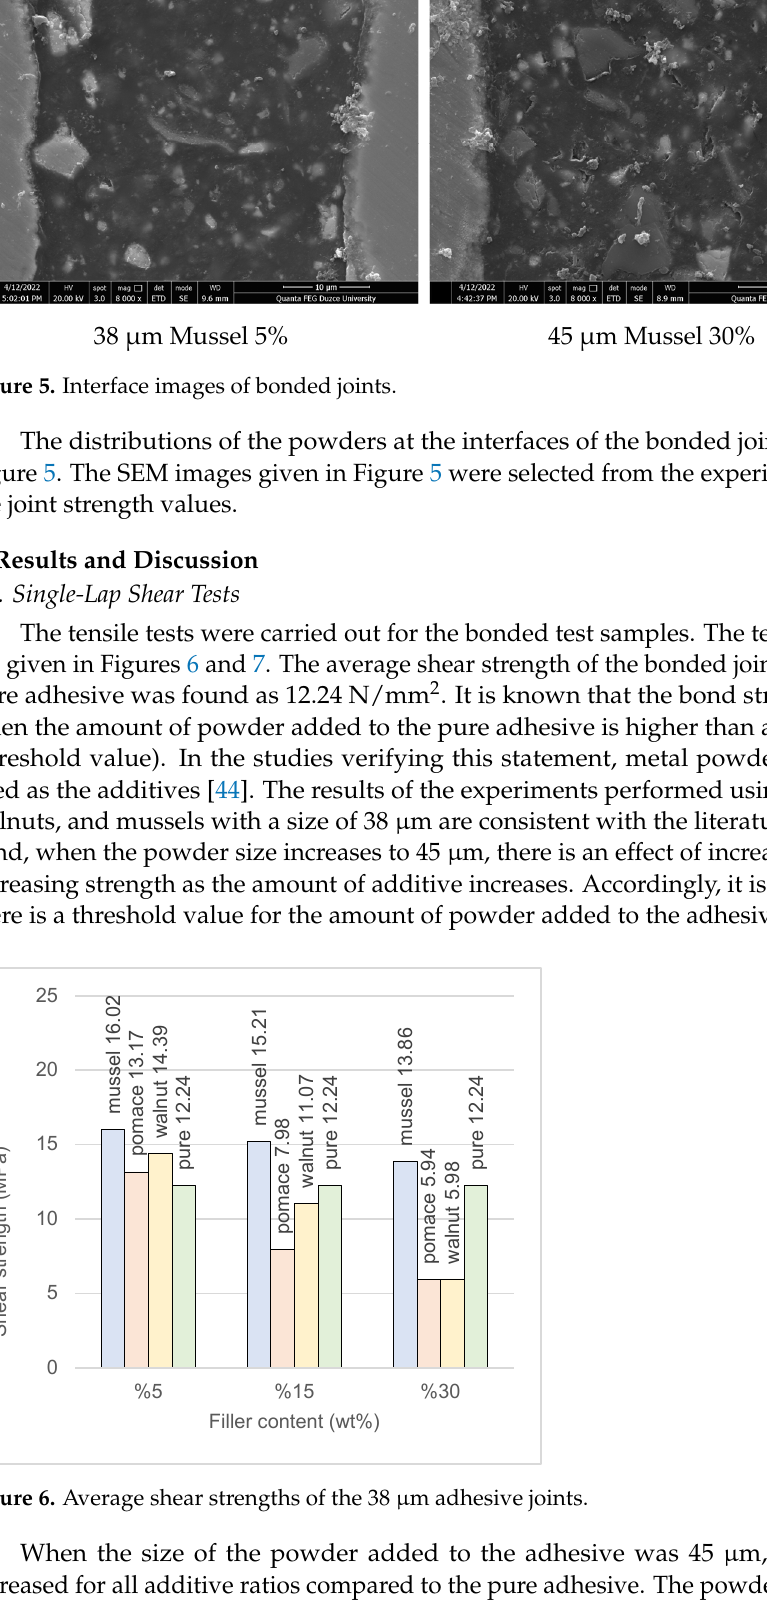
Figure 3 . Average shear strengths of the 38 µm adhesive joints . Figure 6. Average shear strengths of the 38 µ m adhesive